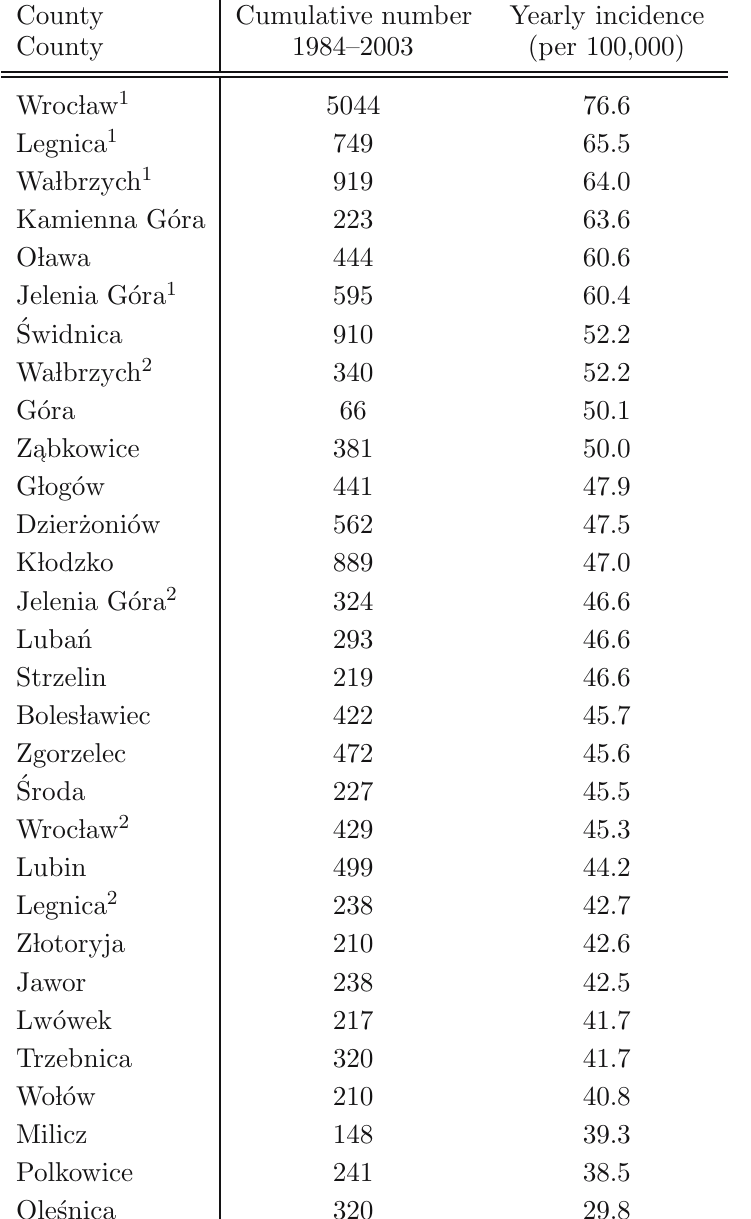
Table 1 Cumulative numbers of breast cancer cases diagnosed between 1984 and 2003 and crude incidence of breast cancer in selected counties of Lower